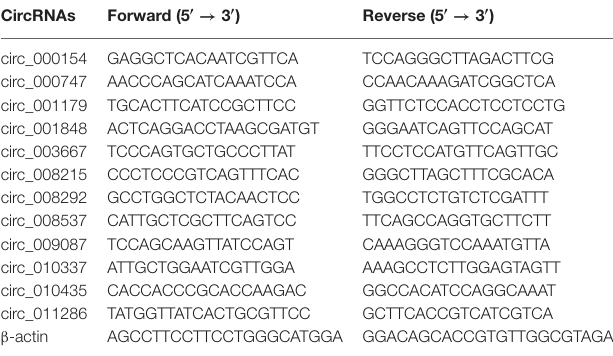
TABLE 1 | A list of primers used in the